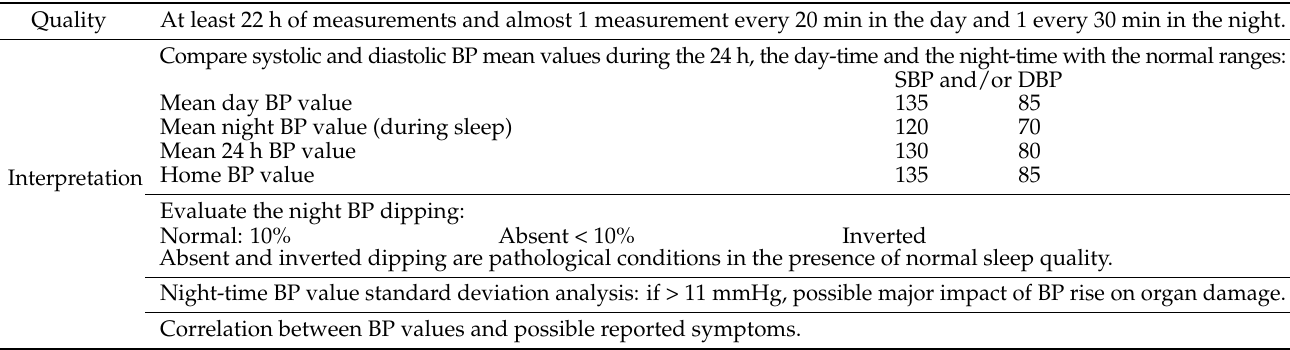
Table 3. Interpretation of ABPM exam